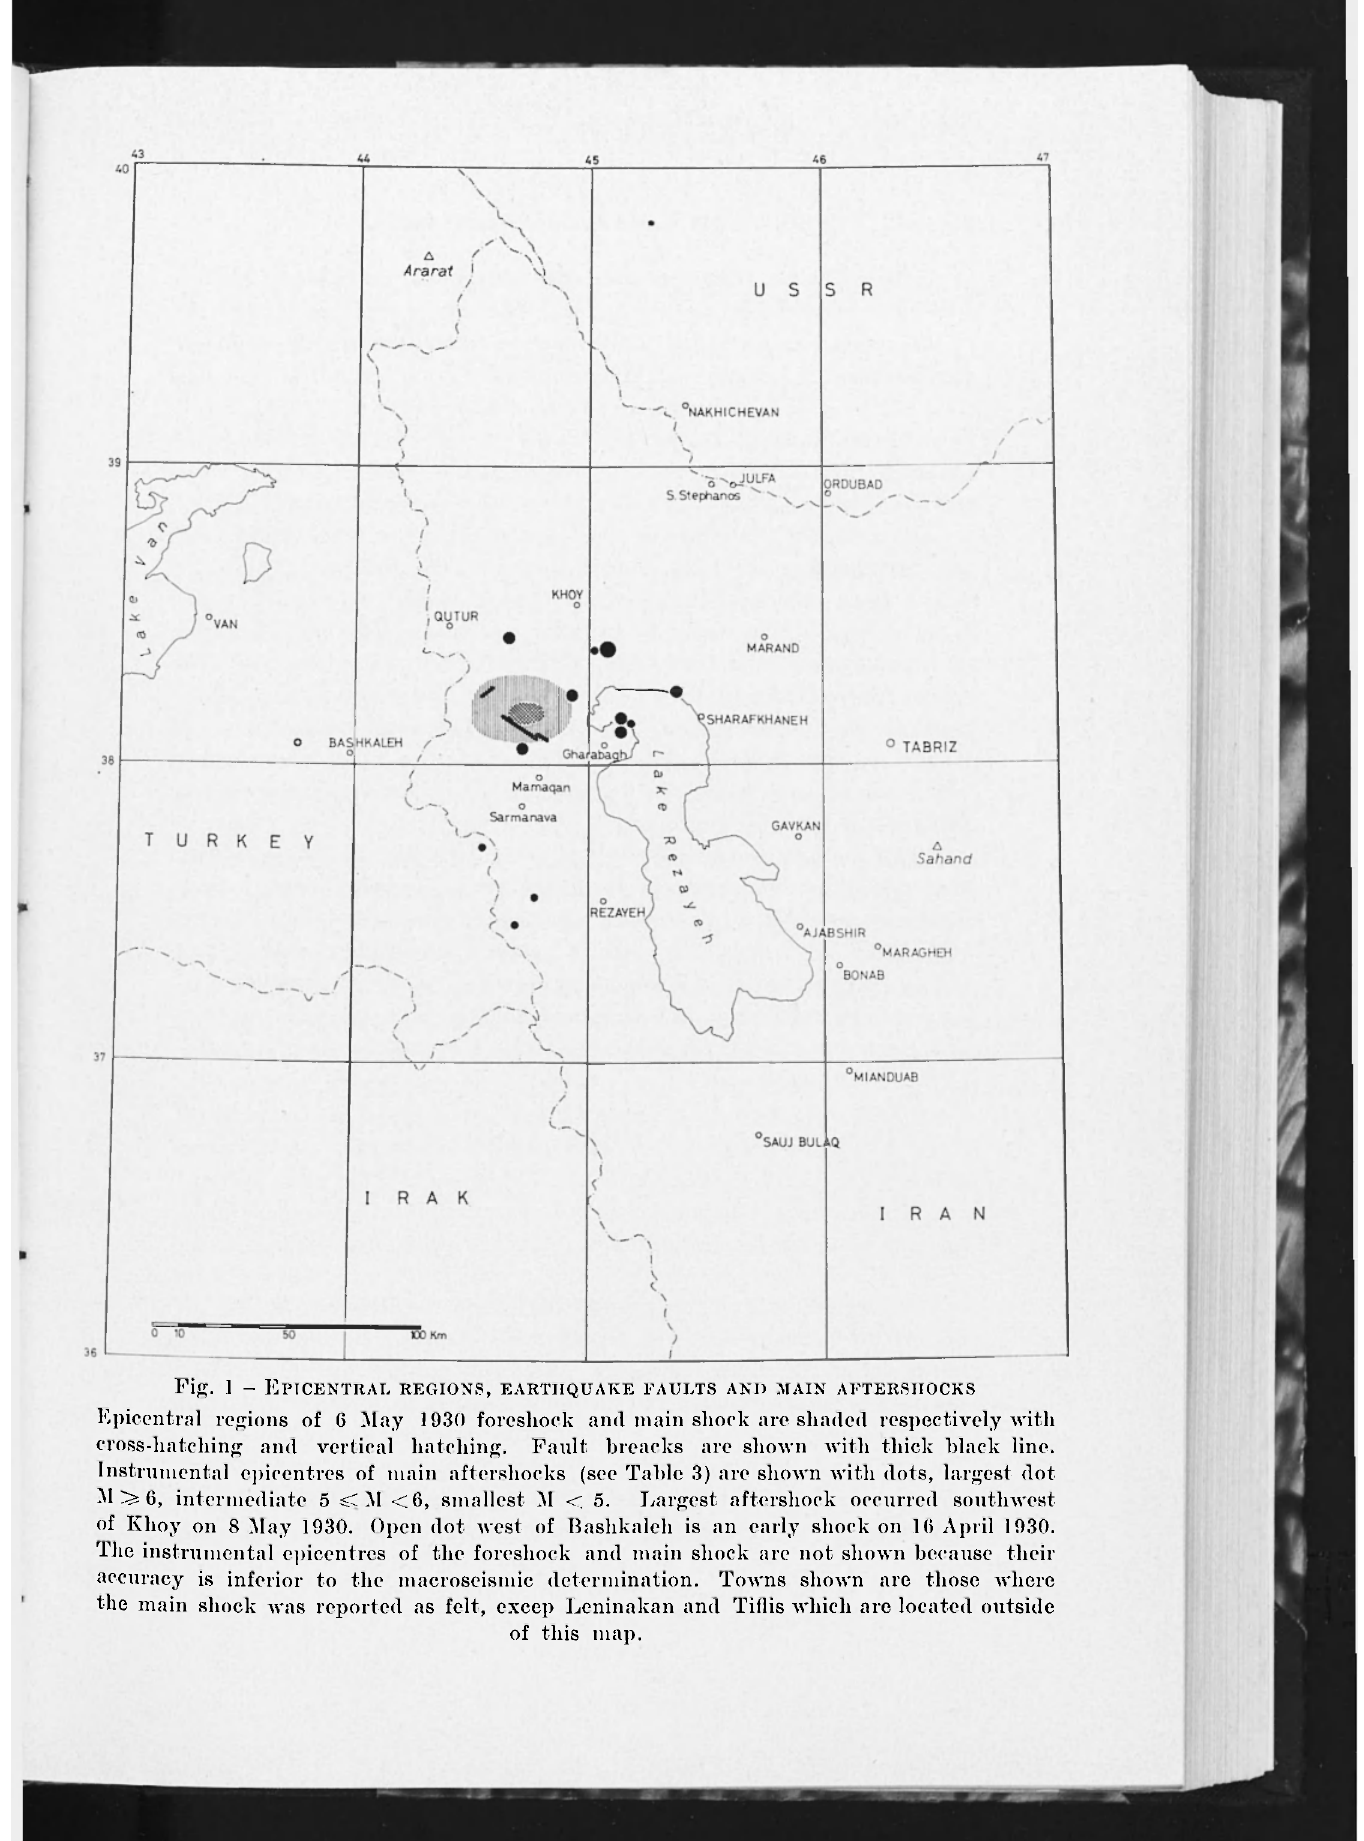
Fig. 1 - EPICENTRAL REGIONS, EARTHQUAKE FAULTS AND MAIN AFTERSHOCKS Epicentral regions of 6 May 1930 foreshoek and main shock are shaded respectively with cross-hatching and vertical hatching. Fault breacks are shown with thick black